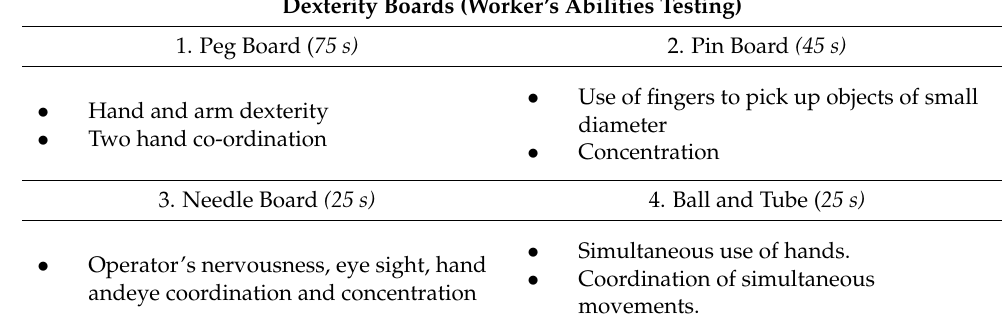
Table 1. Manual dexterity